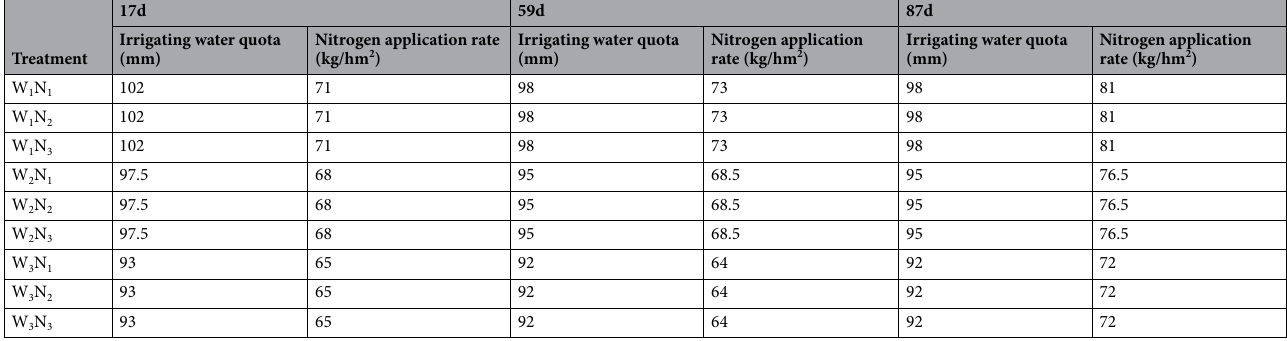
Table 2. Experimental 2 design